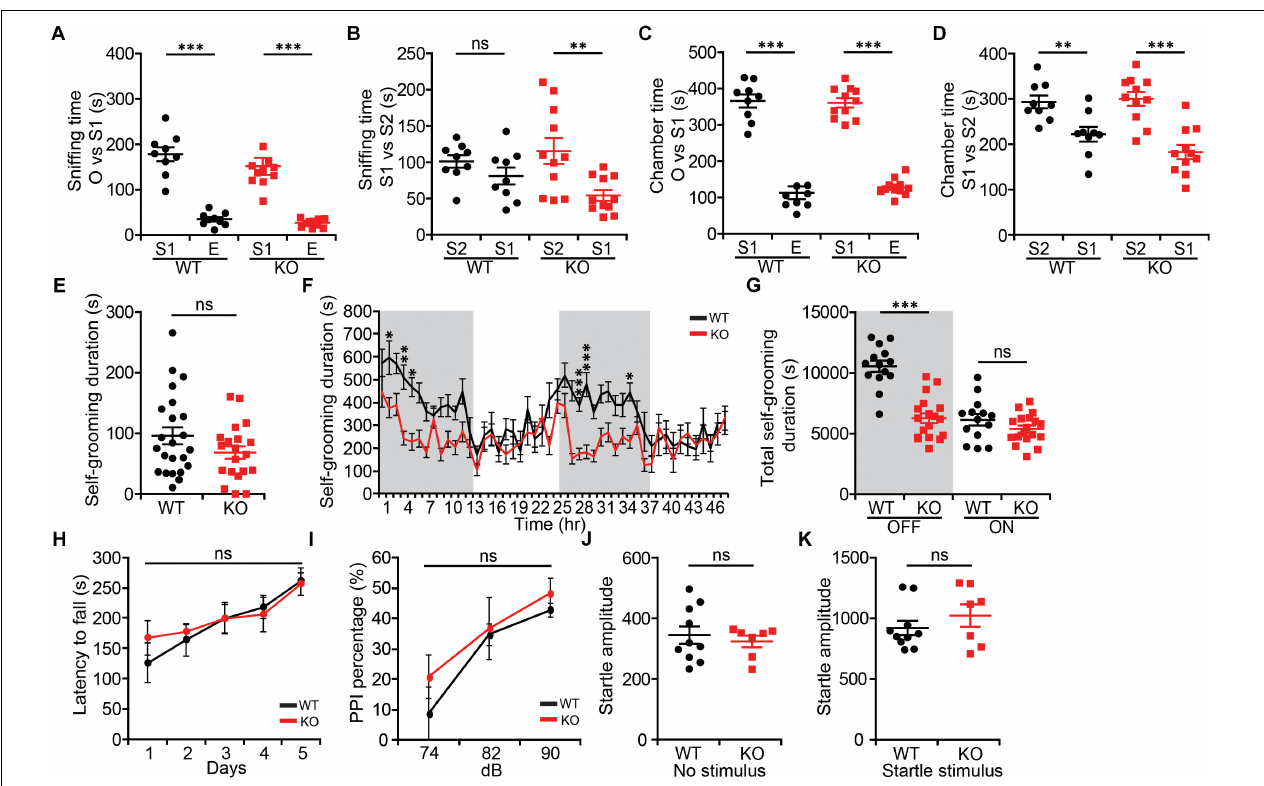
FIGURE 3 | Modestly suppressed repetitive self-grooming but normal social interaction and sensorimotor function in Lrrc4c − / − mice. (A–D) Normal social approach behavior in Lrrc4c − / − mice (2–5 months; male) in the three-chamber test, as shown by time spent sniffing or time spent in the chamber with social (S1) targets and empty (E) chambers. Note that WT mice exhibit only a modest level of social novelty recognition, showing strongly significant recognition of a novel stranger (S2) when assessed by the time spent in chamber, but not time spent sniffing. n = 9 (WT), n = 11 (KO), ∗∗ p < 0.01, ∗∗∗ p < 0.001, ns, not significant, two-way repeated-measures ANOVA with Holm-Sidak multiple comparison test [ (A) interaction, F ( 1 , 36 ) = 0.128, p = 0.7226; genotype, F ( 1 , 36 ) = 1.087, p = 0.3042; subject, F ( 1 , 36 ) = 141.2, p < 0.001; (B) interaction, F ( 1 , 36 ) = 2.691, p = 0.1096; genotype, F ( 1 , 36 ) = 0.2517, p = 0.6189; subject, F ( 1 , 36 ) = 10.48, p = 0.0026; (C) interaction, F